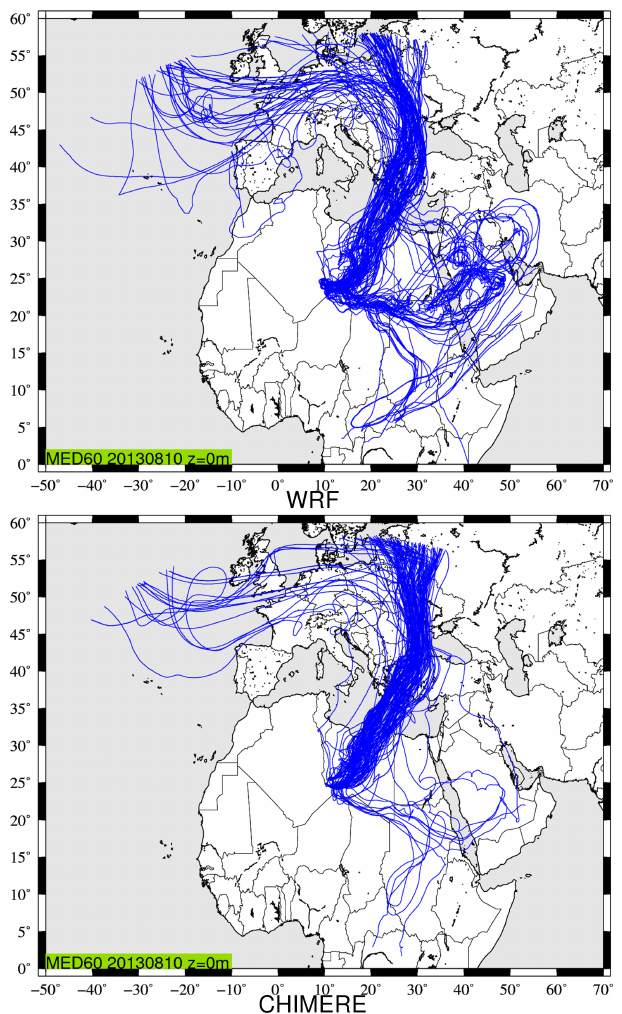
Figure 5. Back trajectories calculated using CHIMERE and WRF modelled meteorological fields. The starting point is at longitude 10 ◦ E and latitude 25 ◦ N, with an altitude of 0ma.g.l. on 10 Au- gust 2013 at 12:00UTC. It corresponds to a case studied during the Chemistry-Aerosol Mediterranean Experiment (ChArMEx) cam- paign (Menut et al., 2015).